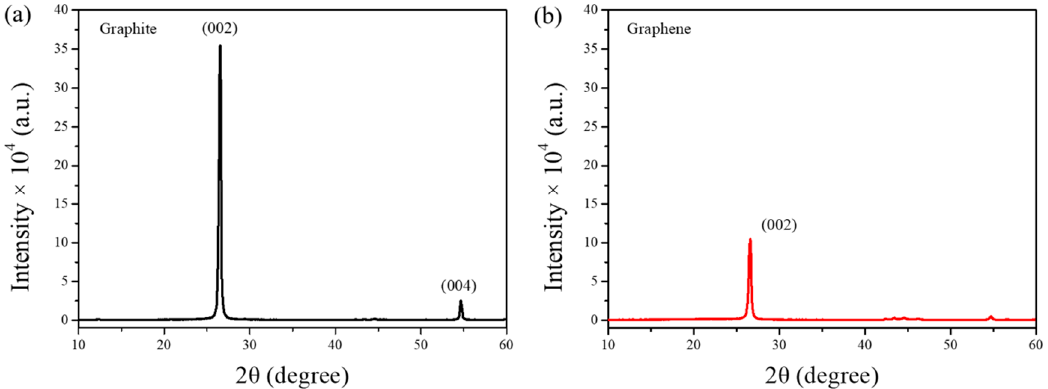
Figure 8. X-ray diffraction ( XRD) spectra of graphite ( a ) and as-prepared graphene ( b ).